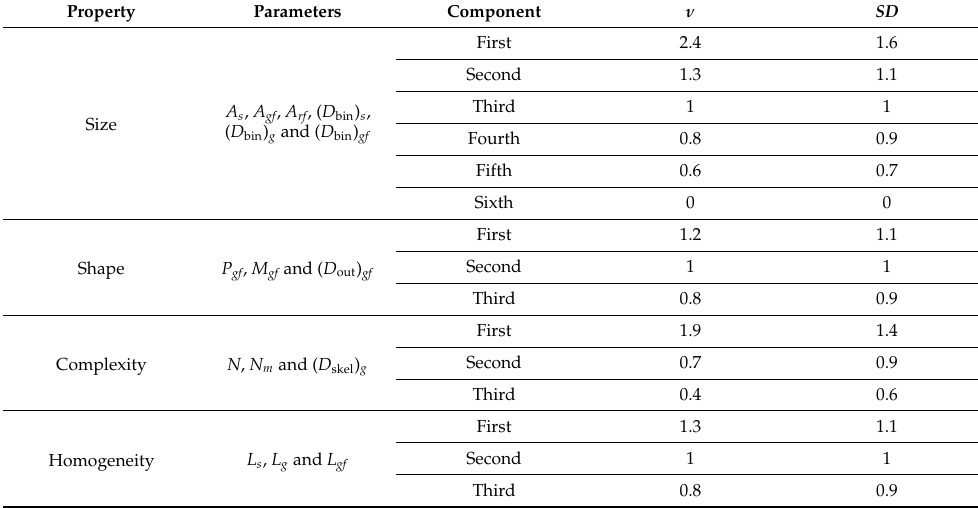
Table 1. The importance of the 15 parameters of astrocytes presented in the basis of principal components. First, reduction to only one parameter was carried out by the examination of variance ( ν ) and standard deviation ( SD ). Afterward, a final conclusion was drawn analyzing the scree plot and